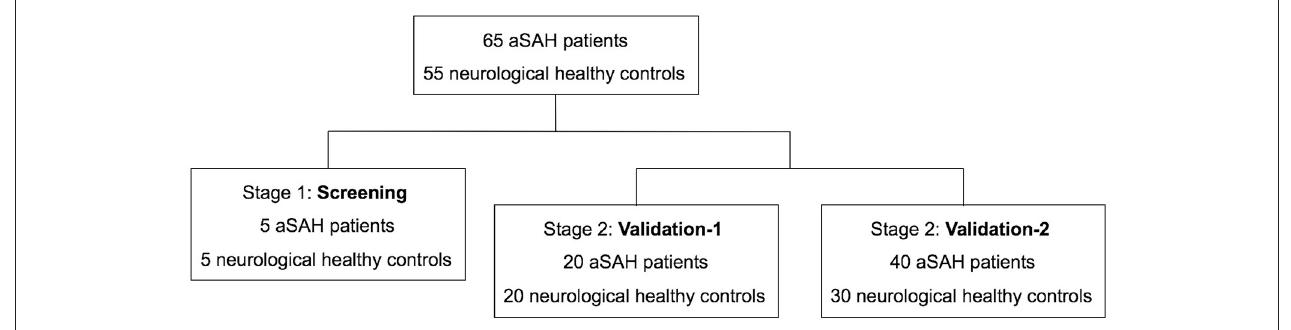
FIGURE 1 | Study flow diagram. aSAH indicates aneurysmal subarachnoid hemorrhage.